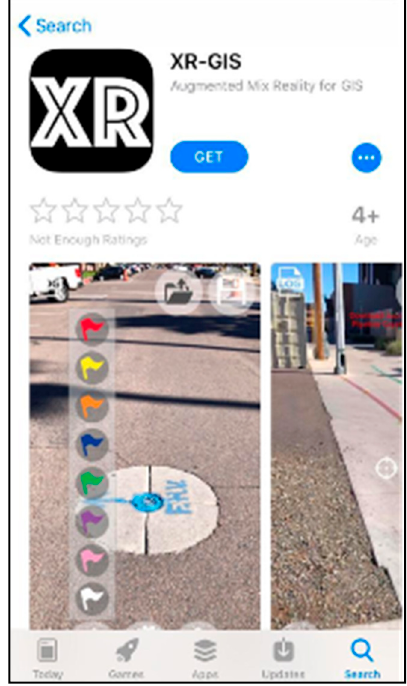
Infrastructures 2019 , 4 , x FOR PEER REVIEW Figure 5. Publishing the extended reality geographic information system (XR-GIS) to the Apple store.